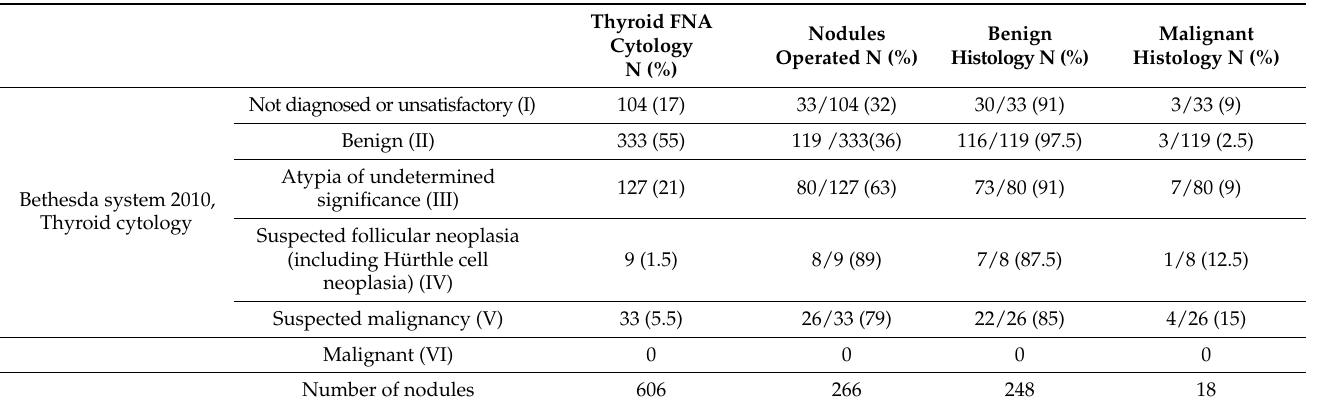
Table 4. Bethesda system 2010—Thyroid cytology and final histology results of thyroid nodules. Number (N) and percentage (%) of thyroids nodules which have Bethesda system FNA cytology compared to operated cases and final histological analysis in each category.